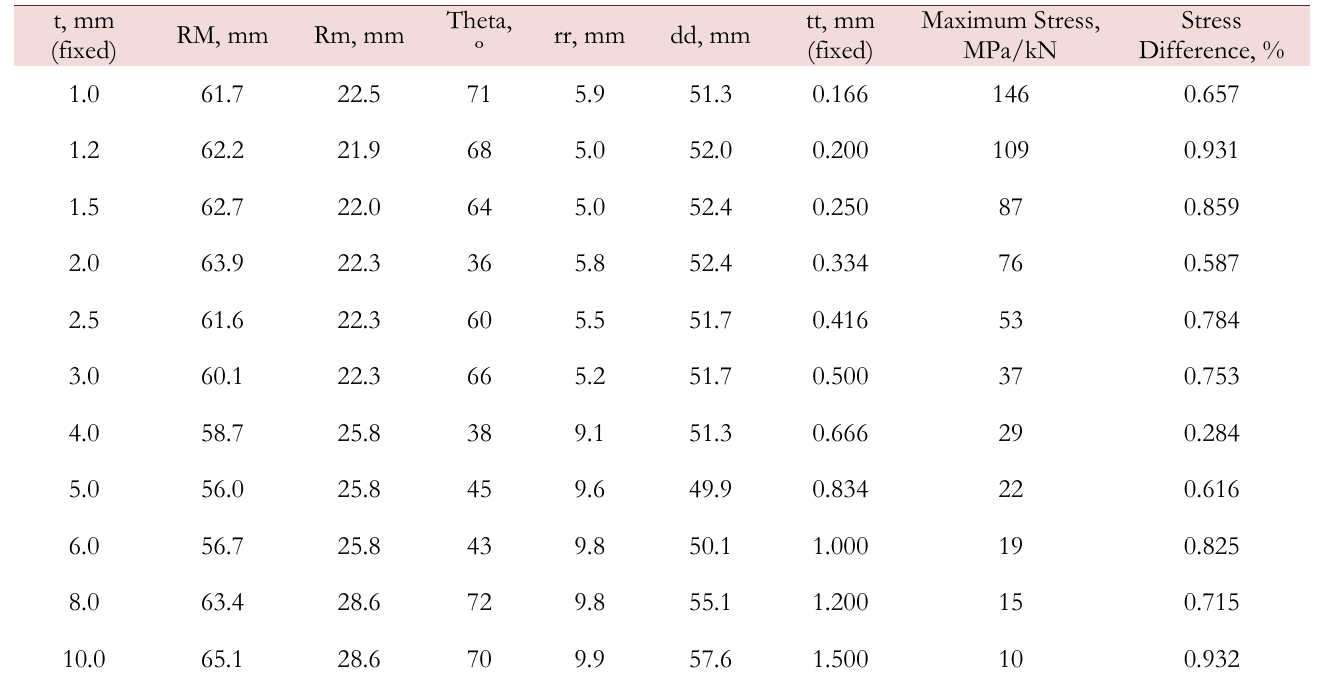
Table 3: Optimal specimen geometry for each Renard series value of arms